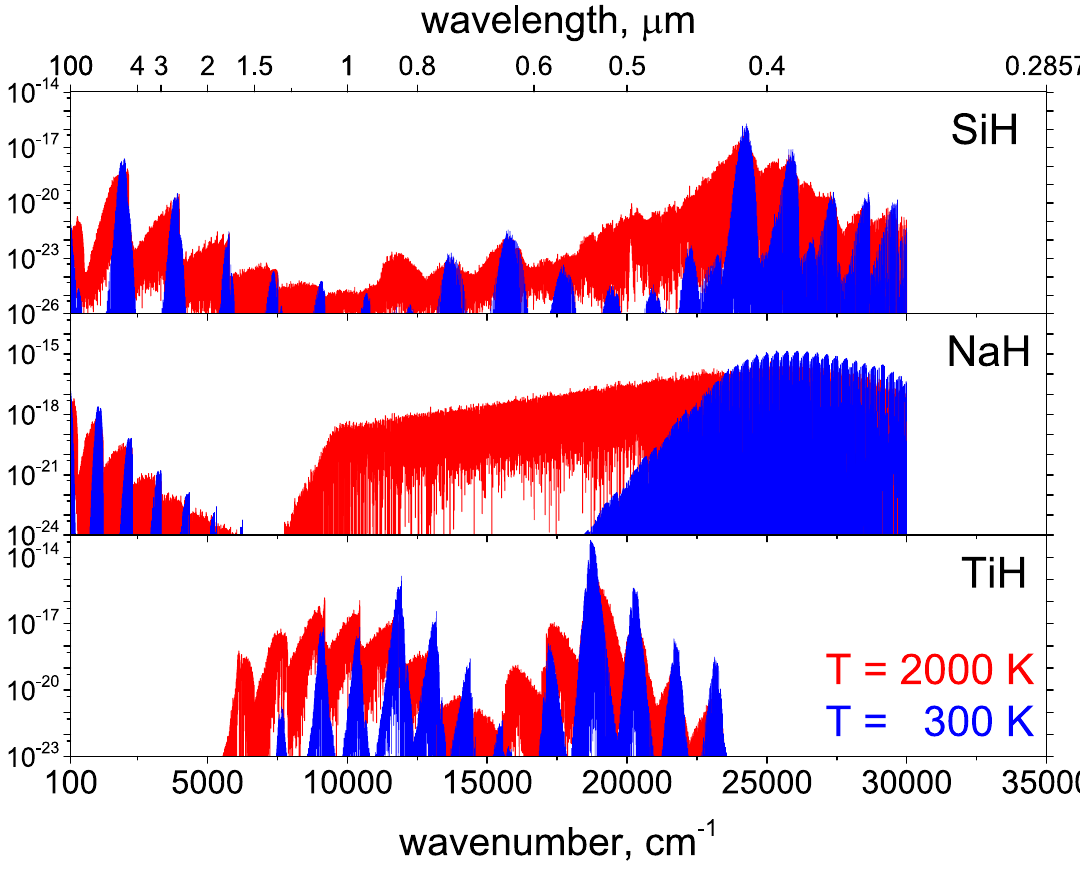
Figure 13. Cross sections for hydride species based on ExoMol line lists for sodium hydride [59] and silicon monohydride [72], and the empirical titanium monohydride line list of Burrows et al.